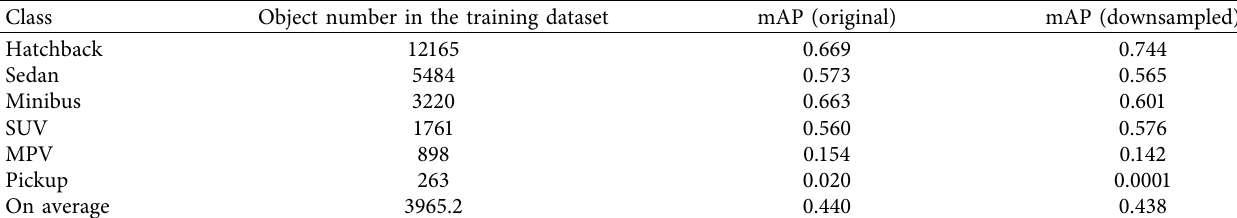
Table 5: Comparison of detection results based on the original training dataset and downsampled dataset.